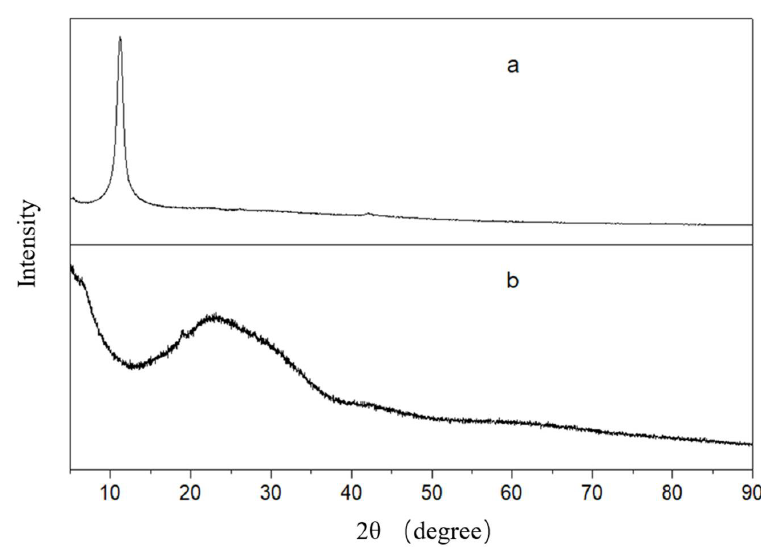
Figure 4. FT-IR spectra of ( a ) GO, ( b ) modified GO.